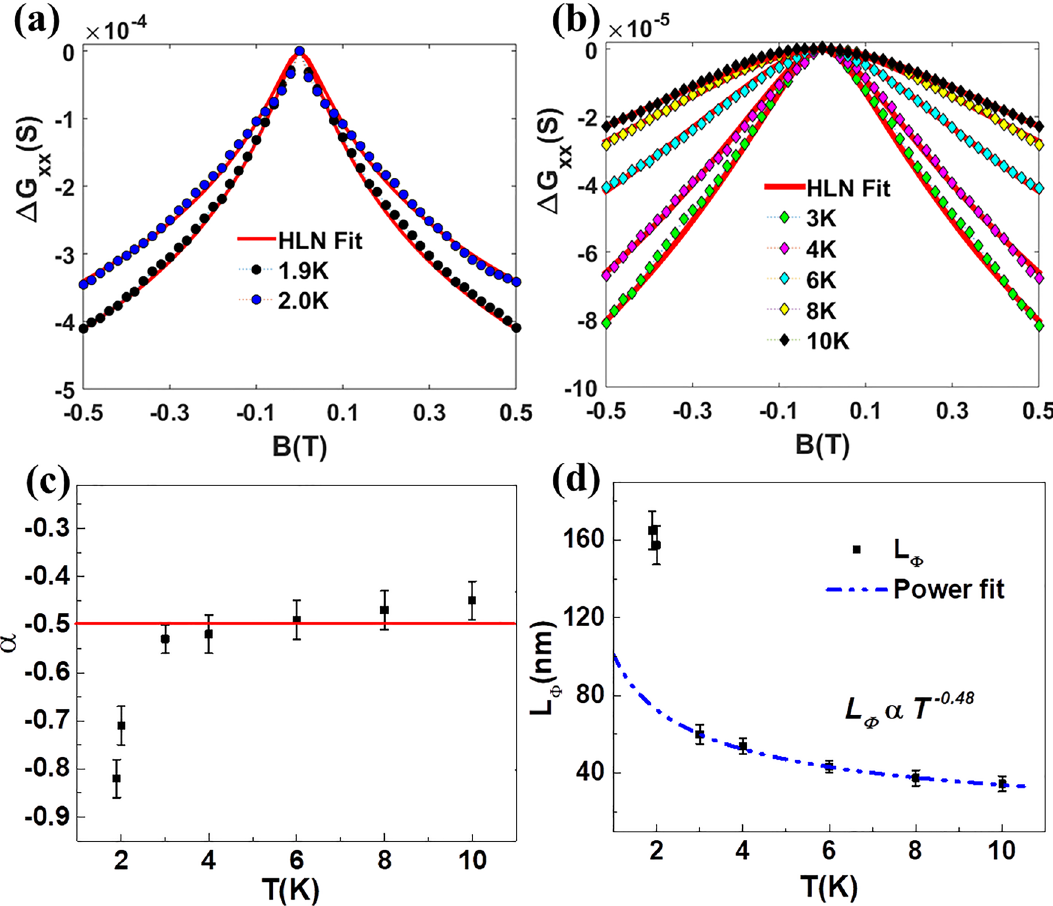
Figure 3. Weak antilocalization effect in YPdBi: ( a ) The HLN fit of magneto-conductance (cid:31) G xx data at 1.9 K and 2 K. ( b ) HLN fitting in range 3 K ≤ T ≤ 10 K. ( c ) Variation of α with temperature. ( d ) Variation of L (cid:31) . with which clearly shows a sharp drop in resistivity by almost two orders of magnitude from 2.2 K down to 0.38 K. The residual resistivity value at the base temperature of the cryostat is 0.05 m (cid:31) cm. A series of R − H measurements were performed at various temperatures with a perpendicularly applied field and the corresponding fractional resistance change (called magneto-resistance or MR) calculated using the formula [ { R ( H ) − R ( 0 ) } / R ( 0 ) ] × 100 where R ( H ) and R ( 0 ) are the resistances of the sample at magnetic field H and zero respectively. Figure 2c shows the MR% of YPdBi recorded at 1.9 K and 2 K with maximum MR of ~ 35% observed at 1.9 K. The full dependence of MR above this temperature is showed in Fig. 2d up to a maximum temperature of 50 K. Although large MR is observed for temperatures 1.9 K and 2 K (Fig. 2c) where the film shows metallic characteristics, the MR decreases to ~ 2.4% at 3 K and vanishes completely at 50 K as seen in Fig. 2d. The prominent cusp in the MR behaviour at low fields is indicative of weak anti-localization (WAL)—a signature of the conductive surface states of topological insulators 30–32 and topological semimetals 18,20,33,34 arising from quantum interference corrections of the diffusive transport. We fit our MR results around low magnetic field region (± 0.5 T) to the well-known Hikami-Larkin-Nagoka (HLN) model, which describes the conductivity of a two dimensional electron systems with strong spin–orbit interactions under an applied magnetic field 35 :